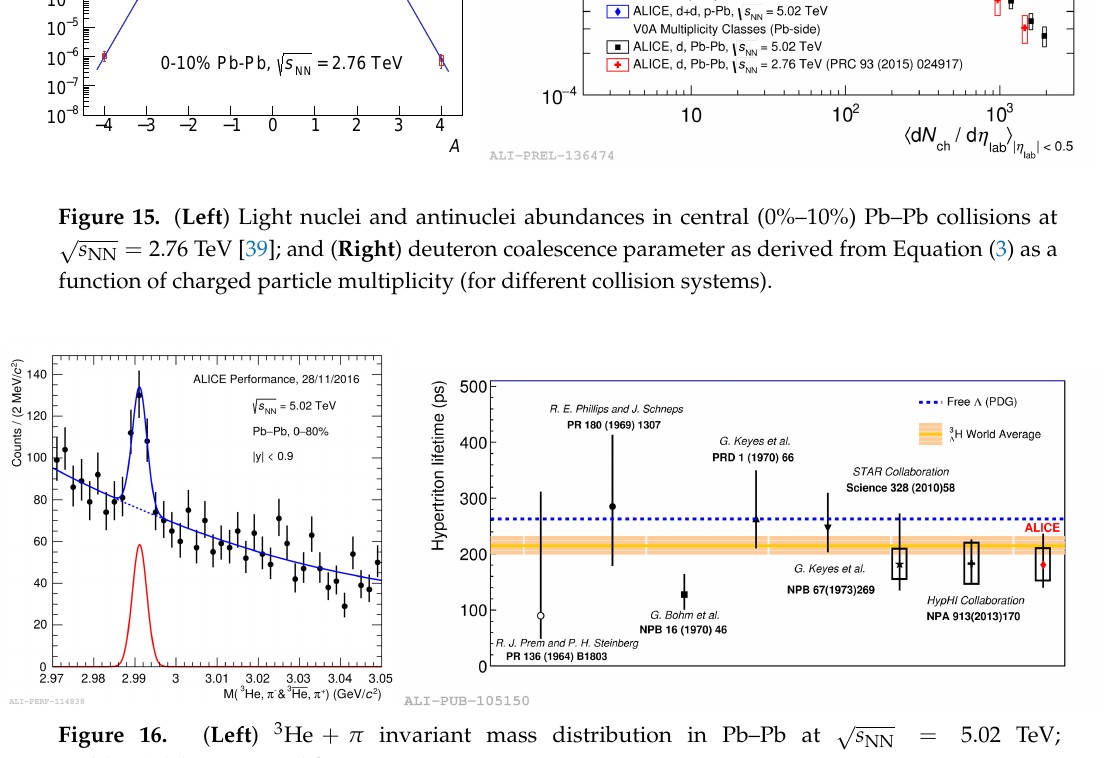
Figure 16. ( Left ) 3 He + π invariant mass distribution in Pb–Pb at and ( Right ) hypertriton